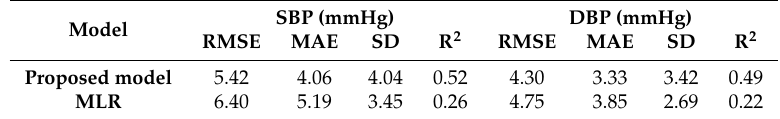
Table 7. Comparison between proposed model and MLR model.